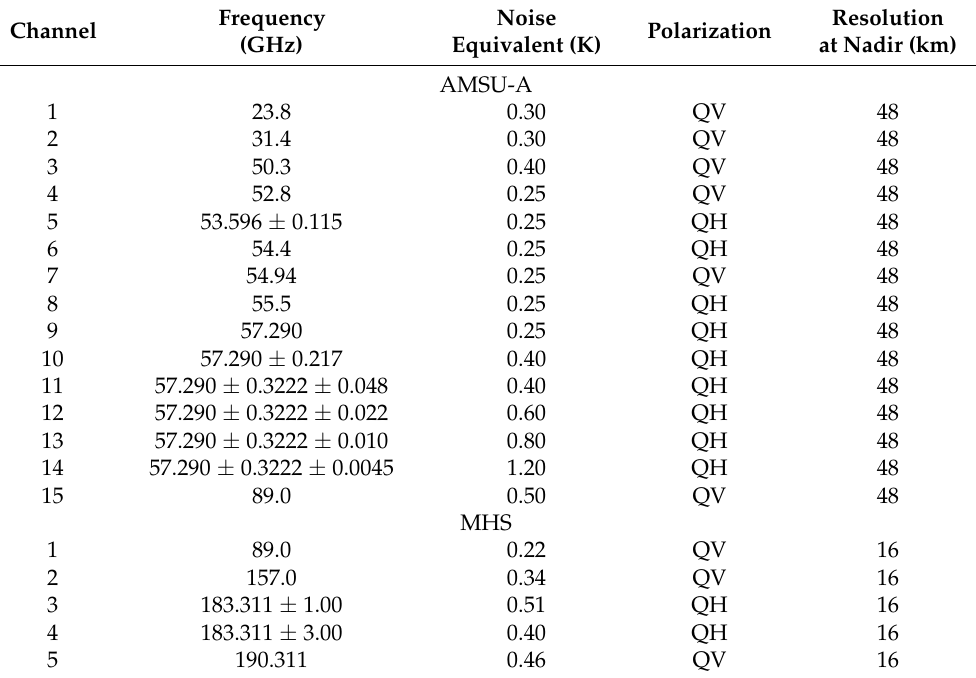
Table 2. As in Table 1 but for AMSU-A and MHS